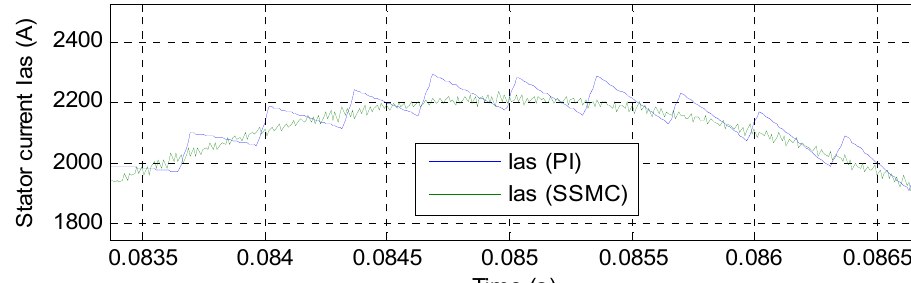
Figure 12. Zoom (Current).